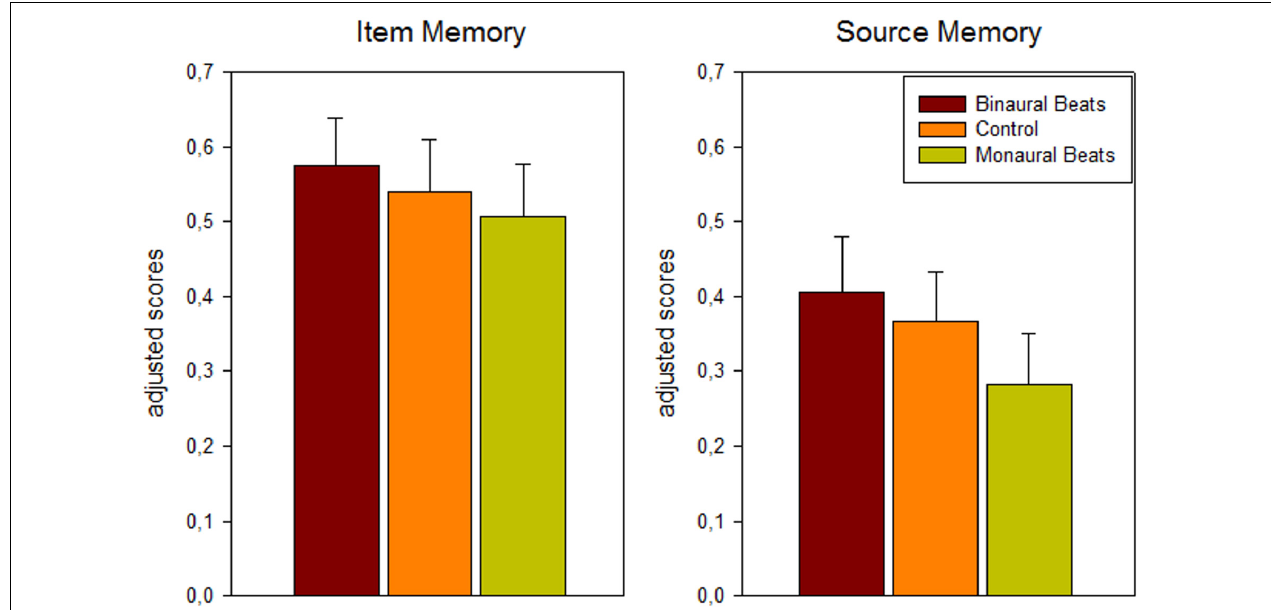
FIGURE 2 | Behavioral results: dependence of memory scores on beat stimulation conditions. Bars show mean ± S.E.M. of adjusted scores for item (hits minus false alarms) and source (correct minus incorrect source association) memory across color and scene runs and across patients ( n =